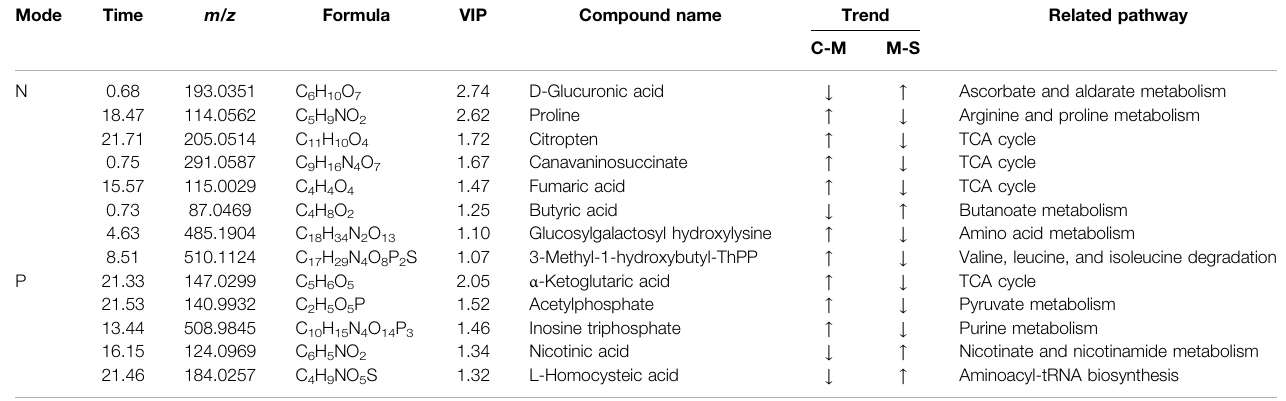
TABLE 2 | Information of different metabolites among groups.